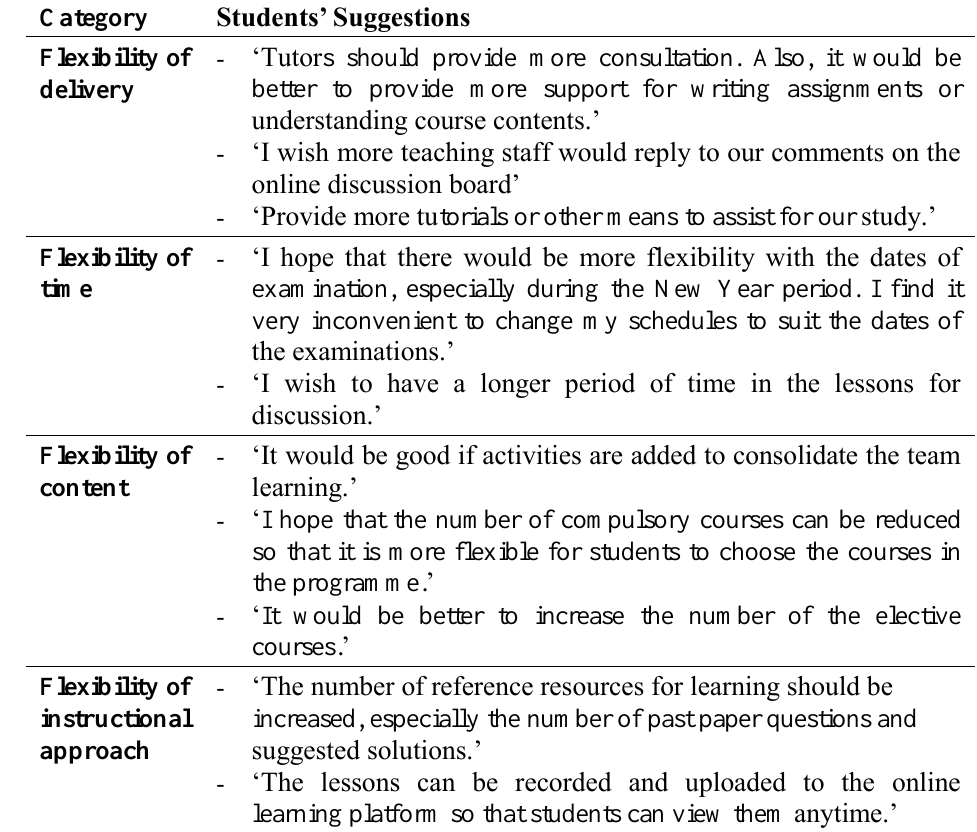
Table 3 Extracts from the students’s suggestions for improving learning